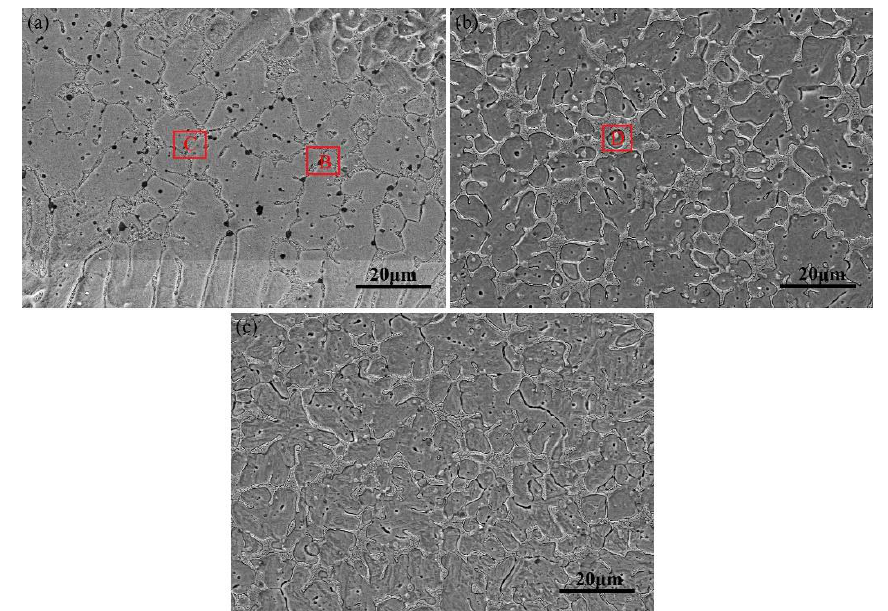
Figure 7. Scanning electron micrograph (SEM) image of coating 2: ( a ) bottom region; ( b ) intermediate region; ( c ) upper region.